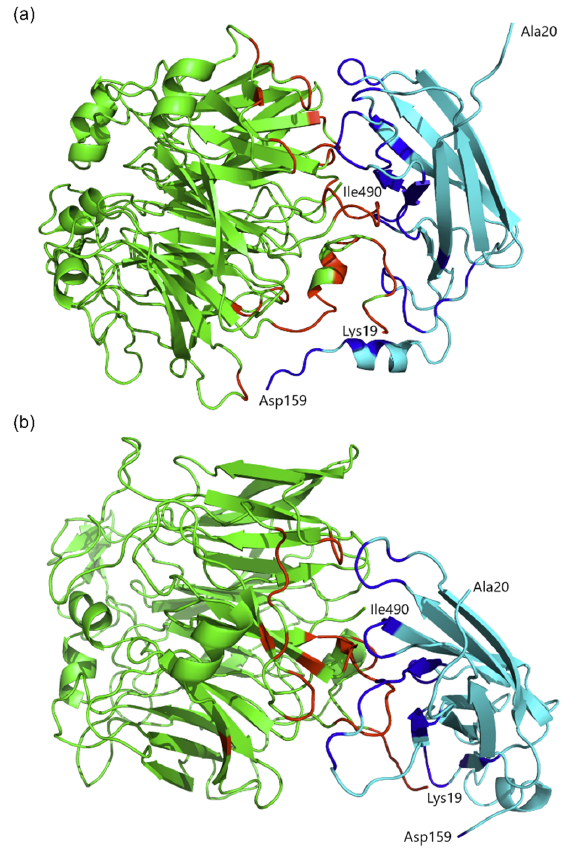
Figure 5. A cartoon representation of the predicted At SBP1– At SAH7 complex (colored in green and cyan, respectively) after the docking experiment ( a ) and the molecular dynamics simulation ( b ). The interfacing residues, calculated by PISA, are colored red ( At SBP1) . Table 1 . List of the residues that are located at the interface between At SBP1 and At SAH7 after the molecular docking experiment and after the molecular dynamics simulation. (A) Interfacing resi- dues of At SBP1 after the docking experiment, (B) interfacing residues of At SBP1 after the MD sim- ulation, (C) interfacing residues of At SAH7 after the docking experiment, (D) interfacing residues of At SAH7 after the MD simulation. A